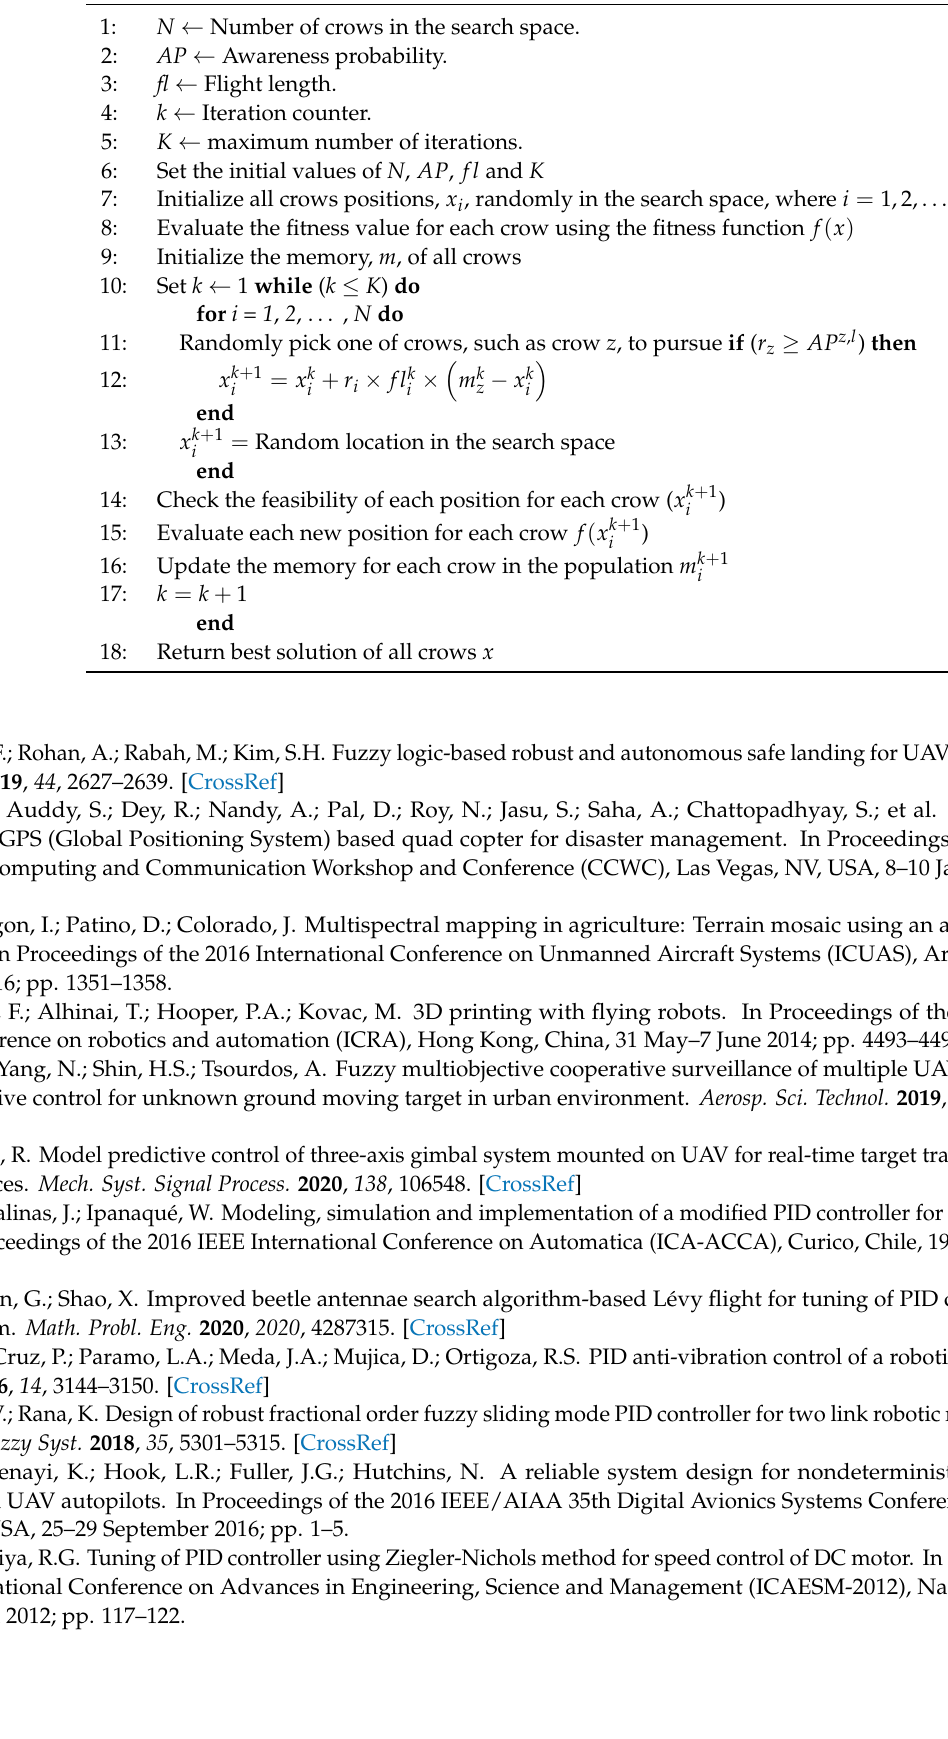
Algorithm A3: Pseudo-code stating the basic steps of the Crow Search